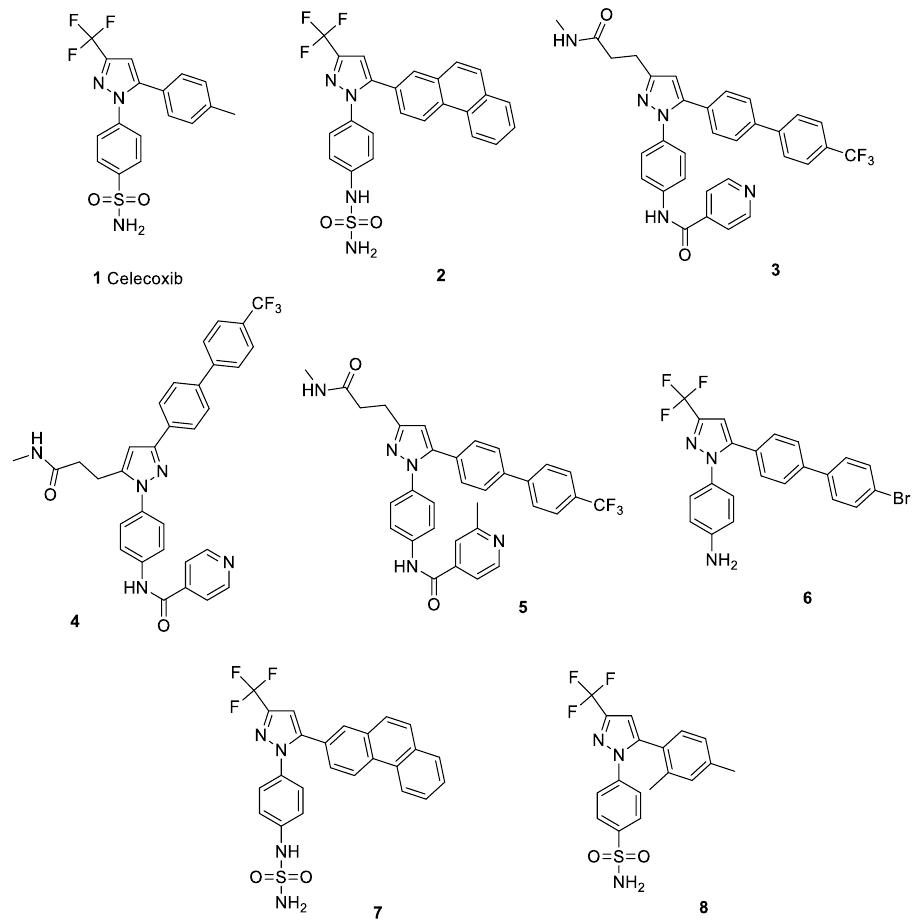
Figure 2. Structure of celecoxib ( 1 ) and its potent derivatives ( 2 – 8 ).